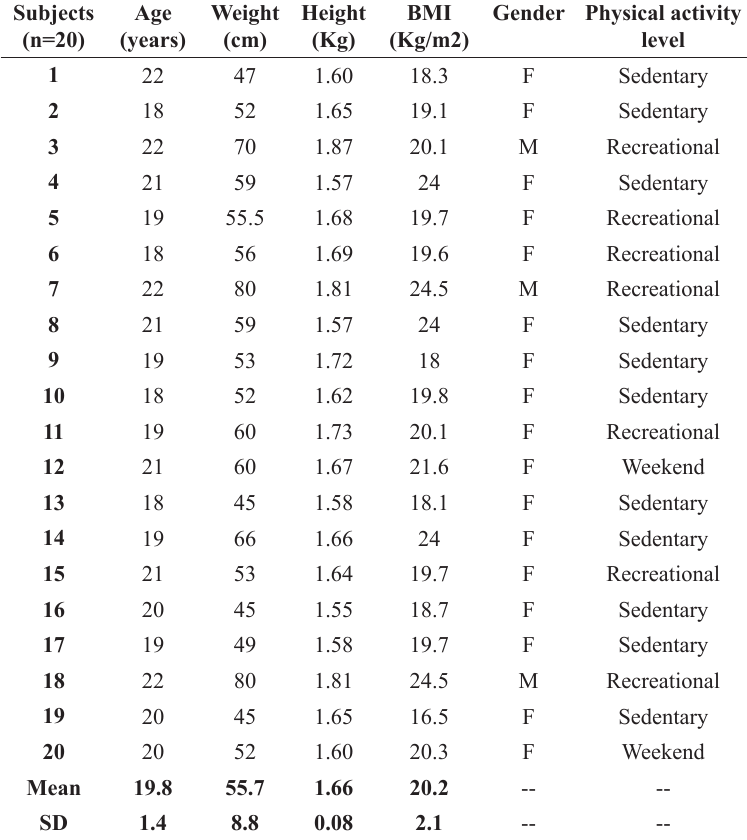
Table 1. Anthropometric characteristics.